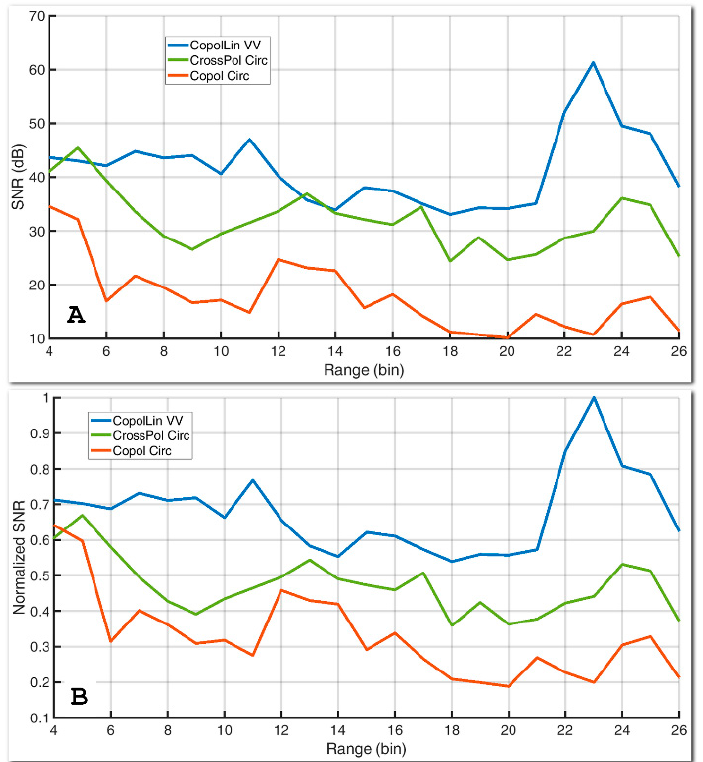
Figure 10. Range profiles (1 bin = 0.5 m), obtained in front of a light pole with three different polarization configurations: VV (blue line), cross-polar circular (green line), co-polar circular (brown line). (A) SNR. (B) Data normalized to the maximum.